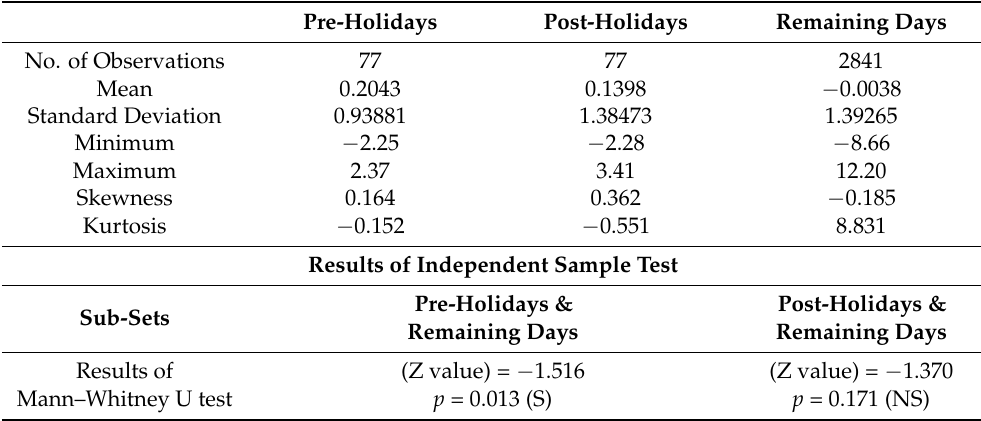
Table 5. The Results of Descriptive Statistics for DFMGI Daily Returns for Pre, Post-Holiday and